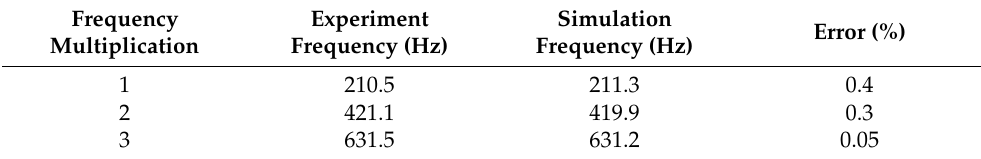
Table 8. Frequency comparison analysis.